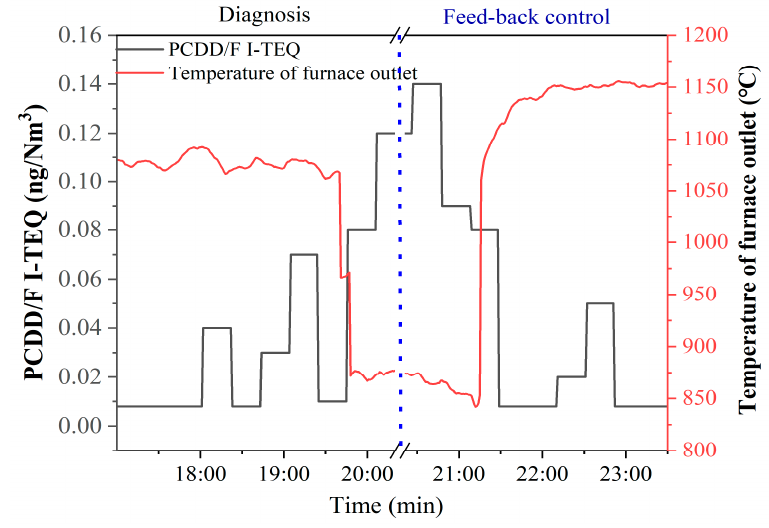
Figure 11. Diagnosis and feedback control of PCDD/F based on the furnace outlet temperature. As shown in Figure 12, PCDD/F emissions increase from 0.06 ng I-TEQ/Nm 3 to 0.14 ng I-TEQ/Nm 3 under the condition that the bed temperature decreases from 800 ◦ C to 774 ◦ C within 4 h. This result indicates that an increase in bed temperature over 800 ◦ C can reduce the formation of PCDD/F. As shown in Figure 13, PCDD/F I-TEQ increases from 0.02 ng I-TEQ/Nm 3 to 0.12 ng I-TEQ/Nm 3 under the condition that the bed pressure decreases from 70 kPa to 60 kPa within 10 min. This result indicates that the plummet of bed pressure can promote the formation of PCDD/F. As for CFB, the low bed pressure results in a low air concentration gradient. Hence, the diffusion coefficient for the air to the waste is low, according to the Fick Law. The increase in PCDD/F emissions is reasonable for the decrease in the bed pressure.